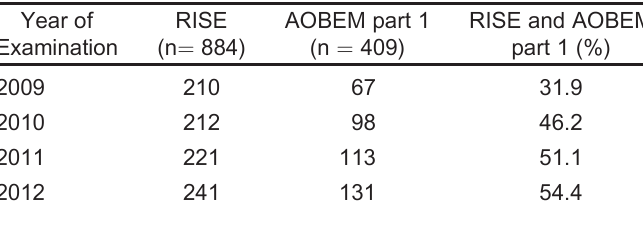
Table 1. The distribution of American Osteopathic Board of Emergency Medicine (AOBEM) Part 1 test takers by post graduate year-4 residents who took the Resident In-Service Examination (RISE) from 2009 to 2012. These residents (n ¼ 409) were the subjects on whom data were reported.